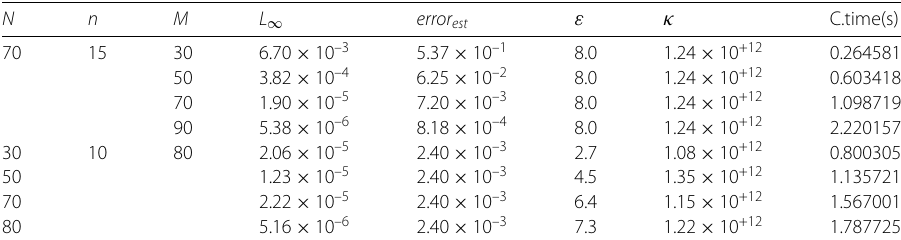
Table 5 The results are obtained for α = 0.7, x ∈ [0,1], and t = 1